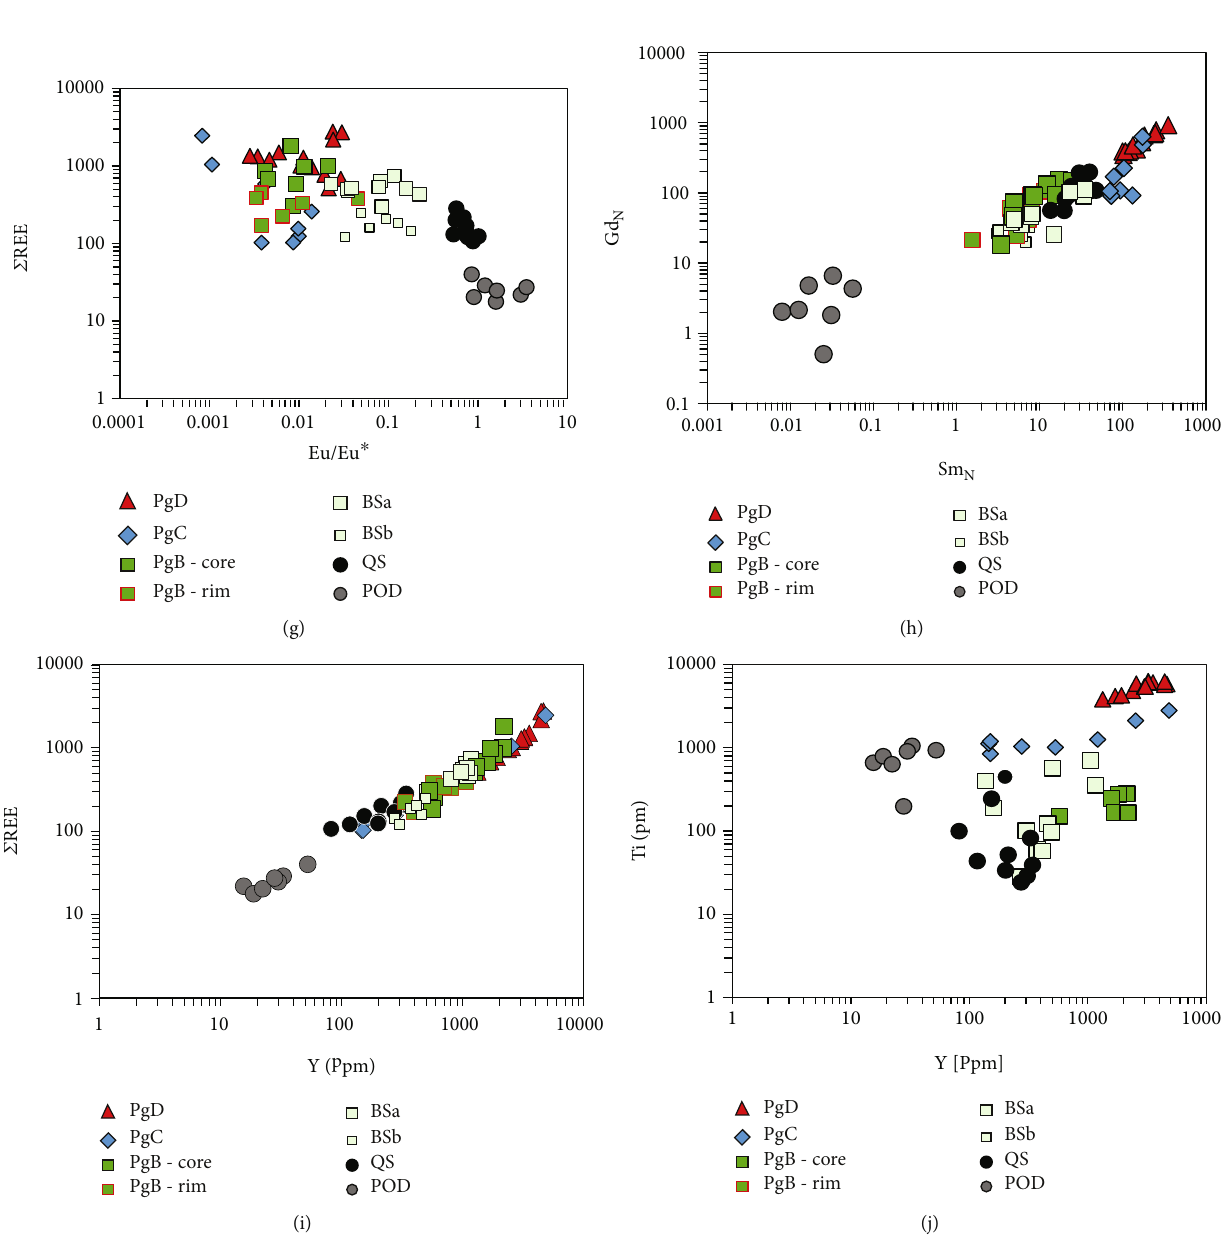
versus Gd . Sm and Gd are the N N N N